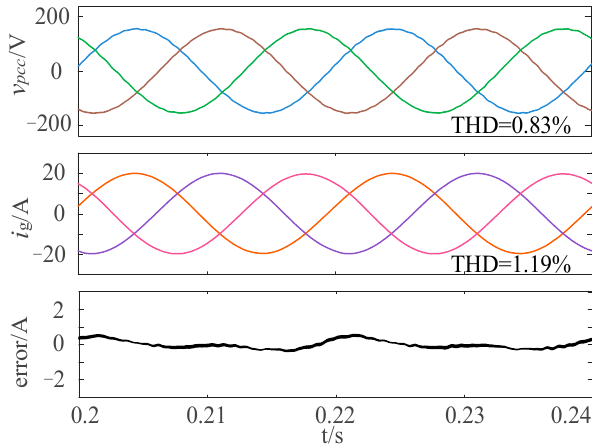
Figure 12. Steady ‐ state responses when Lg is 3 mH.